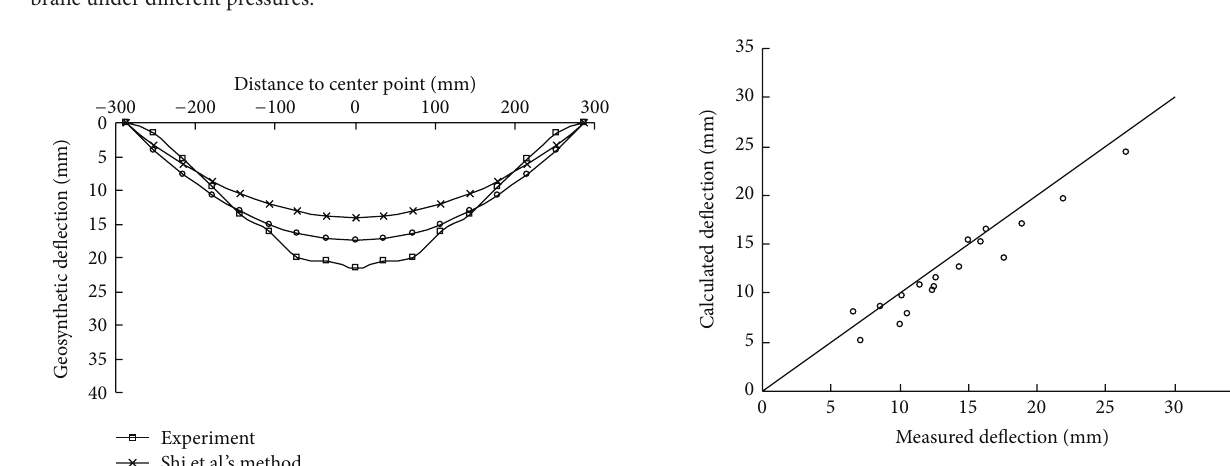
Figure 14: Experimental versus calculated